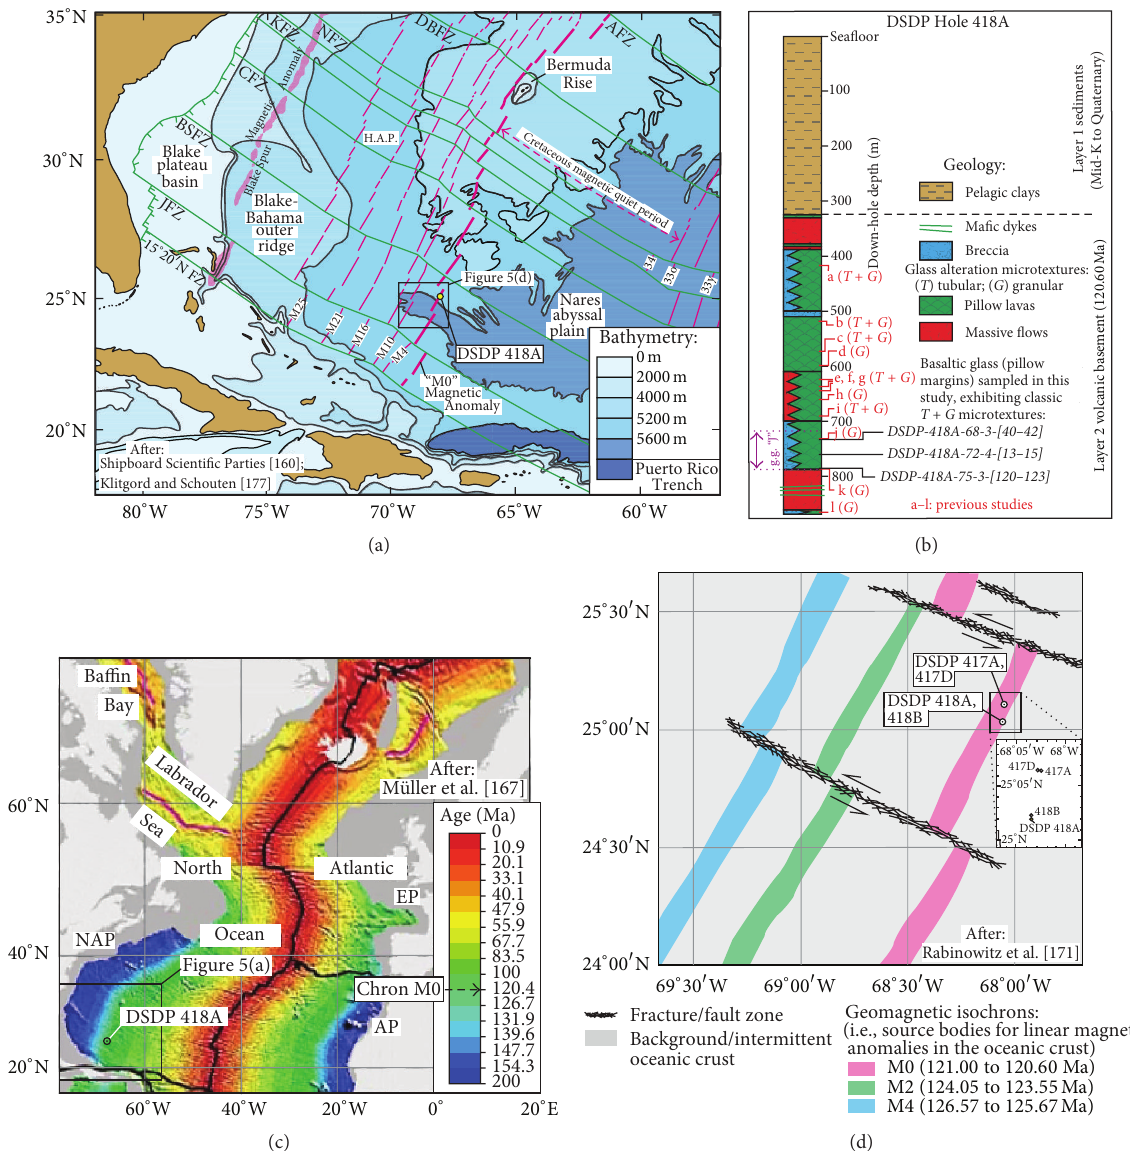
Figure 5: Geological maps (and stratigraphic column) of the North Atlantic region highlighting the position of DSDP Hole 418A within the context of regional patterns of lithospheric age and seafloor spreading magnetic anomalies. (a) Bathymetry, seafloor spreading magnetic anomalies (pink lines), and fault/fracture zones (green lines) of the southwestern North Atlantic Ocean (after [160, 177]). HAP denotes Hatteras Abyssal Plain. Fracture zones (FZ) include the Atlantis (AFZ), Delaware Bay (DBFZ), Norfolk (NFZ), Kane (KFZ), Carolinas (CFZ), Blake Spur (BSFZ), Jacksonville (JFZ), and 15 ∘ 20 󸀠 N FZ. (b) Stratigraphic column for DSDP 418A (after [160–162]) showing the locations of basaltic glass pillow margin samples in which classic “tubular” ( 𝑇 ) and “granular” ( 𝐺 ) alteration microtextures have been documented at the glass-palagonite interface in this (black) and previous studies (red). The black dashed line demarcates the top of volcanic basement, and zigzags represent interbedding of lithologic units. The volcanostratigraphic zone in which glass group “J” occurs [161, 162] is denoted in purple (g.g. “J”) and corresponds to a geochemically coherent volcanic (glass) interval from which all three glass samples were collected in this study. Samples a–l from previous studies (shown in red) correspond to a— 418A-30-3-[4–6 ] in Furnes and Staudigel [33] and Furnes et al. [59]; b— 418A-43-1-[80–82 ] in Fliegel et al. [100]; c— 418A-49-2-[41–45] in Staudigel et al. [27] and Furnes et al. [59]; d— 418A-52-5-[75–80] in Furnes et al. [11] and Furnes et al. [59]; e— 418A-55-4-[112–114] in Furnes et al. [11], Staudigel et al. [27], Furnes et al. [59], and Fliegel et al. [100]; f— 418A-56-5-[129–132] in McLoughlin et al. [28] and Furnes et al. [59]; g— 418A-57-5-[12-13] in Furnes et al. [59]; h— 418A-59-3 in Furnes et al. [59]; i— 418A-62-4-[64–70] in Furnes et al. [11], Staudigel et al. [27], McLoughlin et al. [28], McLoughlin et al. [31], Furnes et al. [59], and Furnes et al. [61]; j— 418A-68-3-[32–38] in Furnes et al. [59]; k— 418A-76-1-[4–7] in Furnes et al. [59]; l— 418A-86-5-[24–32] in Furnes et al. [59]. (c) Map showing lithospheric age in the North Atlantic Ocean, highlighting the location of DSDP 418A and Chron “M0” on which it lies (after M¨uller et al. [167]). Tectonic plates: AP: African Plate; EP: Eurasian Plate; NAP: North American Plate. (d) Close-up geological/geophysical map showing the location of DSDP 418A (and other nearby holes) in the context of local patterns of seafloor spreading magnetic anomalies and fracture/fault zones [160, 171]. The age intervals for geomagnetic isochrons M0, M2, and M4 are from Channell et al.